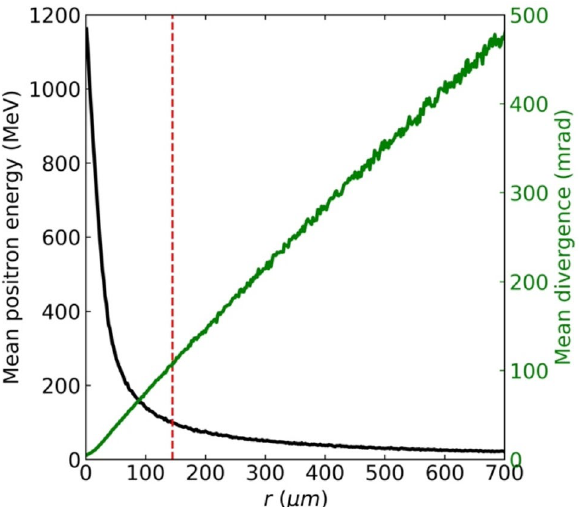
Figure 2. Radial dependence of positron beam characteristics. The mean positron energy at r , < E ( r ) > , is shown as a black curve. The dashed red line represents r median , defined in Fig. 1. The mean divergence of positron at r , < θ( r ) > , is shown as a green line. The driver electron energy is 5 GeV, and the lead converter thickness is L rad .